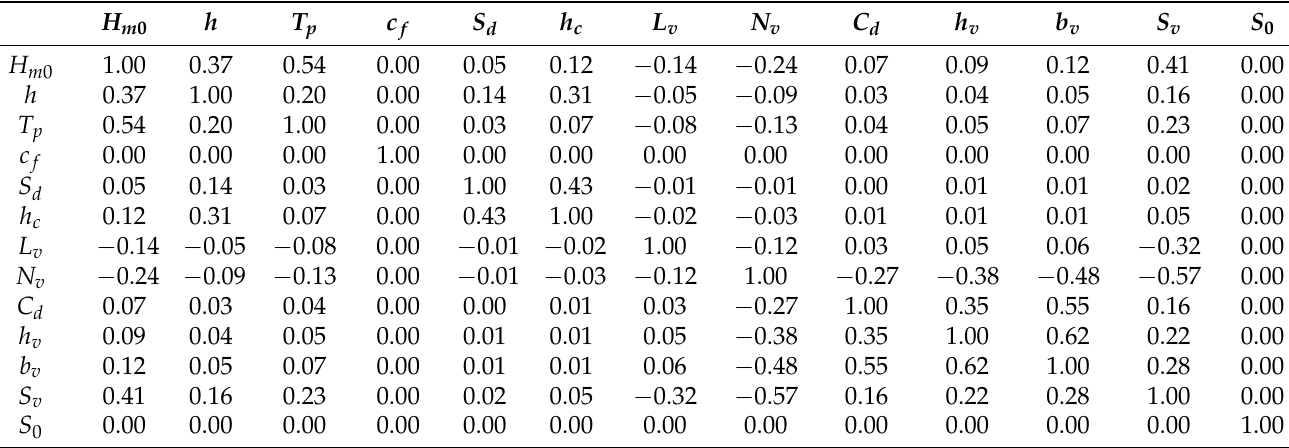
Table 5. Correlation matrix of stochastic model for salt marshes, also see Figure 10. Highest correlation is 1.00, lowest is 0.00. Positive and negative values show positive and negative correlations. The correlations other than the ones in Figure 8 have been calculated using Equation (1). Similar correlation matrix for mangroves nonparametric Bayesian network (NPBN) is presented in Supplementary